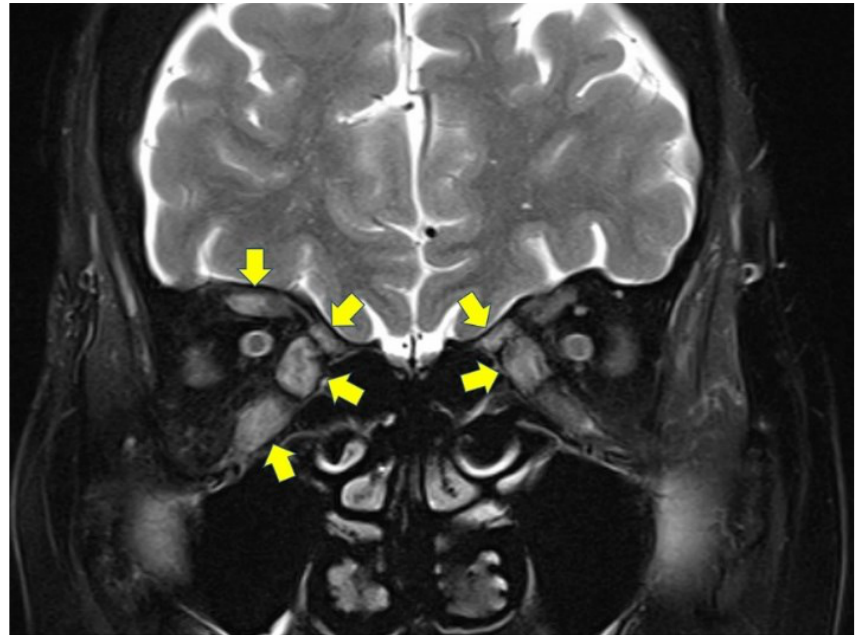
Figure 1. A fat-suppressed coronal T2-weighted magnetic resonance image indicating inflammation in multiple extraocular muscles